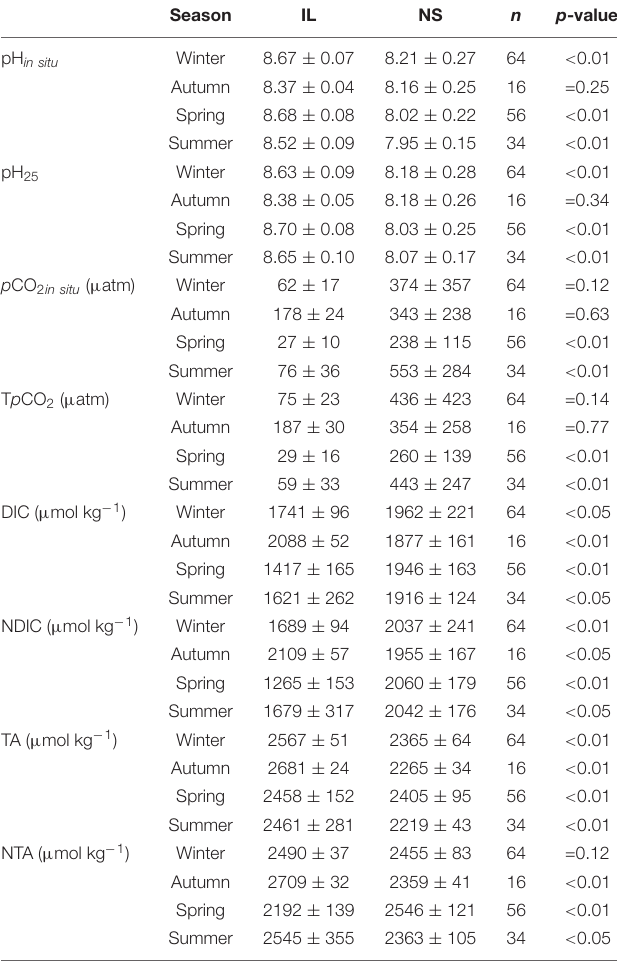
TABLE 1 | A summary of the mean ± standard deviation of surface seawater pH in situ , pH 25 , p CO 2 in situ , T p CO 2 , TA, NTA, DIC, and NDIC along with number of samples (n) at the inner lagoon (IL) and the northern shore (NS) sites in four different